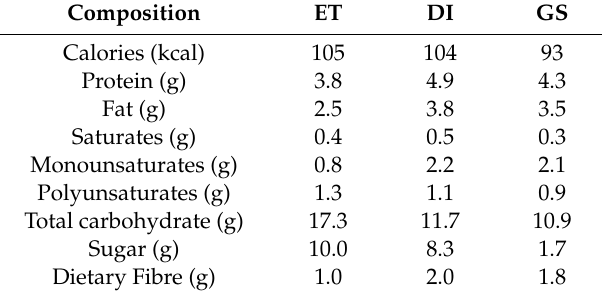
Table 1. Macronutrient composition of the oral nutritional supplements per 100